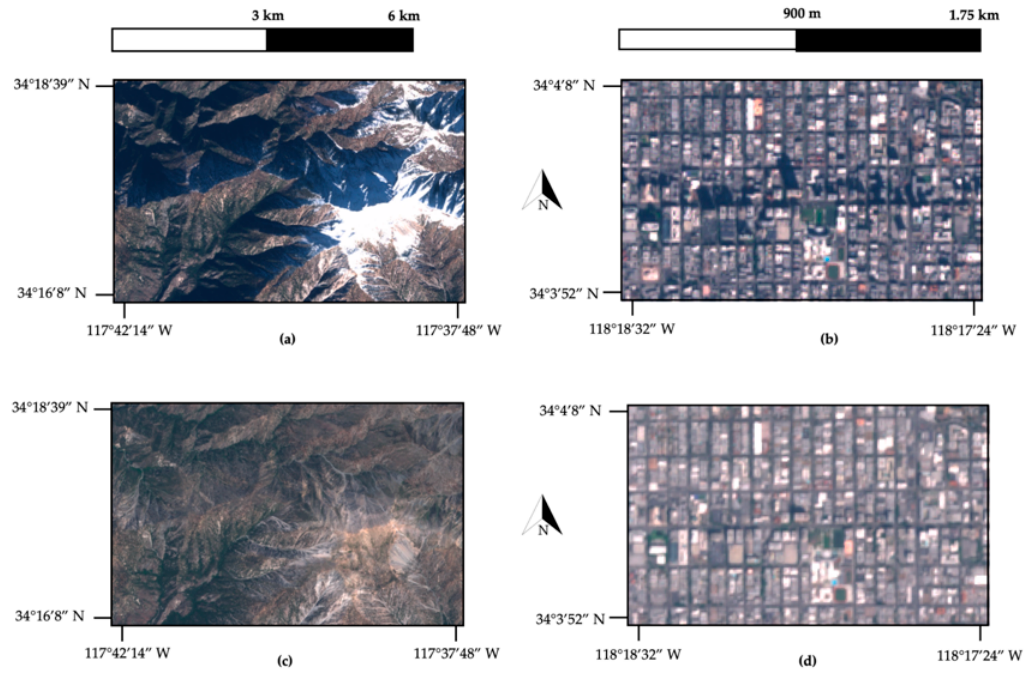
Figure 4. 10 m Sentinel-2 imagery was used to improve land cover classification accuracy in non-urban areas and urban shadow-classified regions of SoCAB. Compared to a single 2018 10 m image: ( a ) Mt. San Antonio in Angeles National Forest; ( b ) Wilshire Center, Los Angeles, calculating the median per pixel value over a 6-month period significantly reduced the effects of shadows and snow from: ( c ) topographically complex mountainous regions; ( d ) urban building shadows.